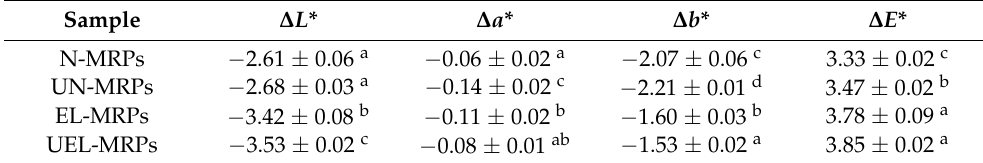
Table 2. Color changes of various MRPs.